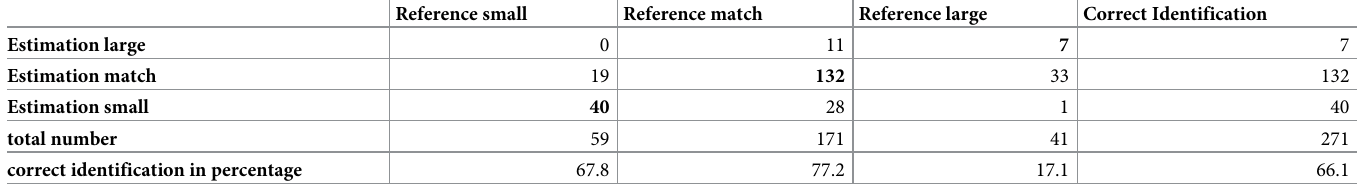
Table 2. Correct identification of cochlea